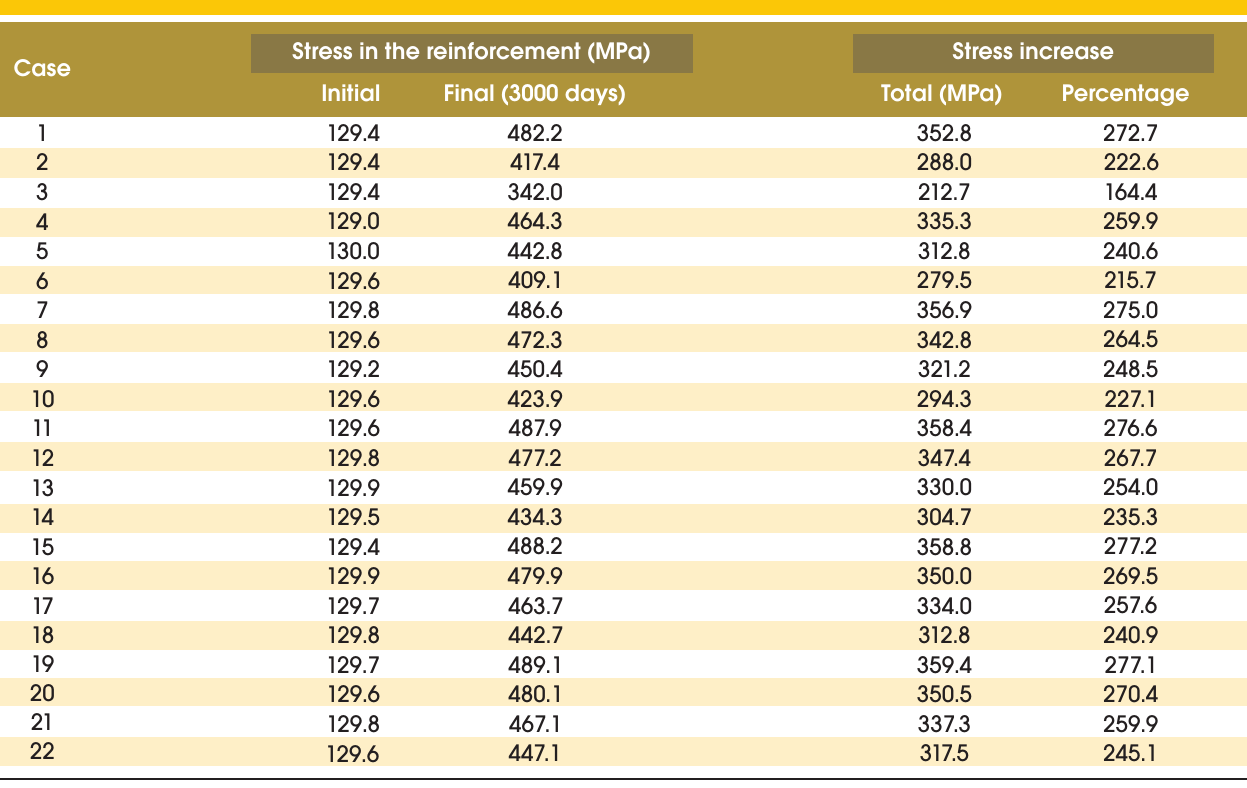
Table 3 – Normal stresses on the reinforcement steel bars